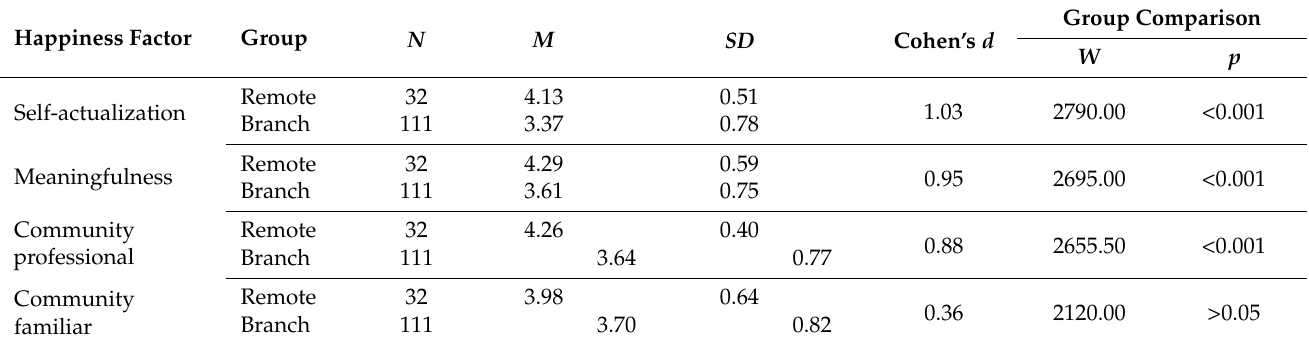
Table 4. Descriptive statistics and group comparisons on happiness